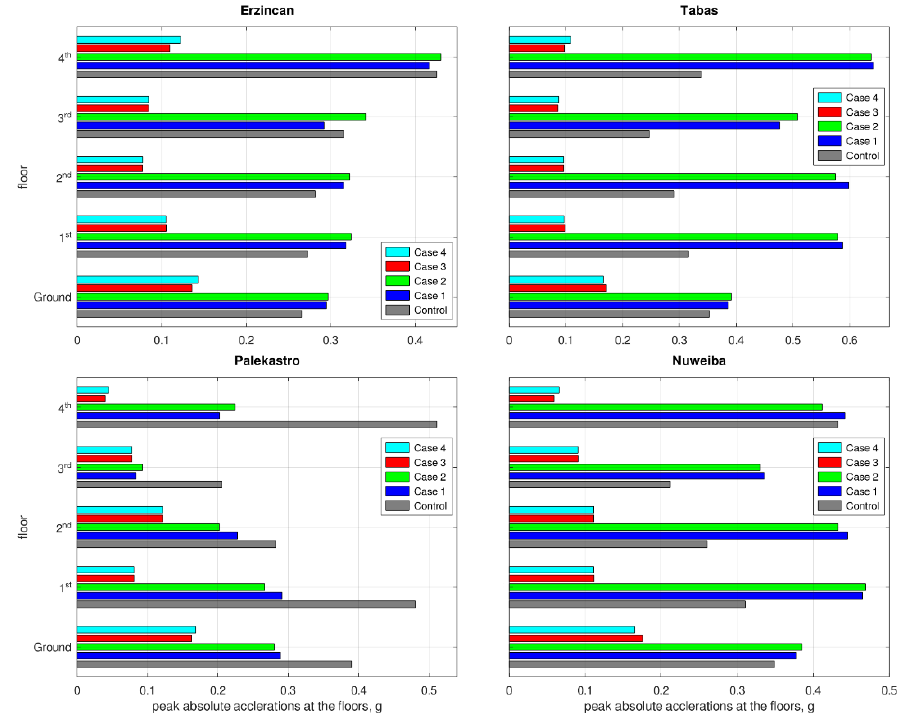
Figure 7. Peak floors ’ acceleration responses to each earthquake.